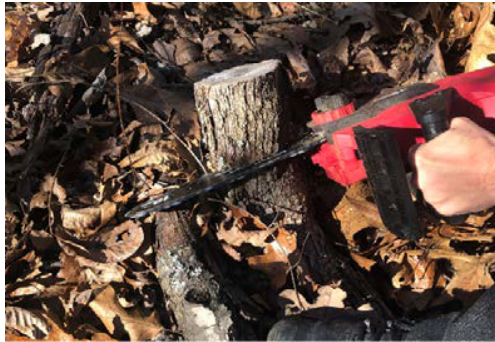
Fig. 2. Course woody debris placed in the incubation